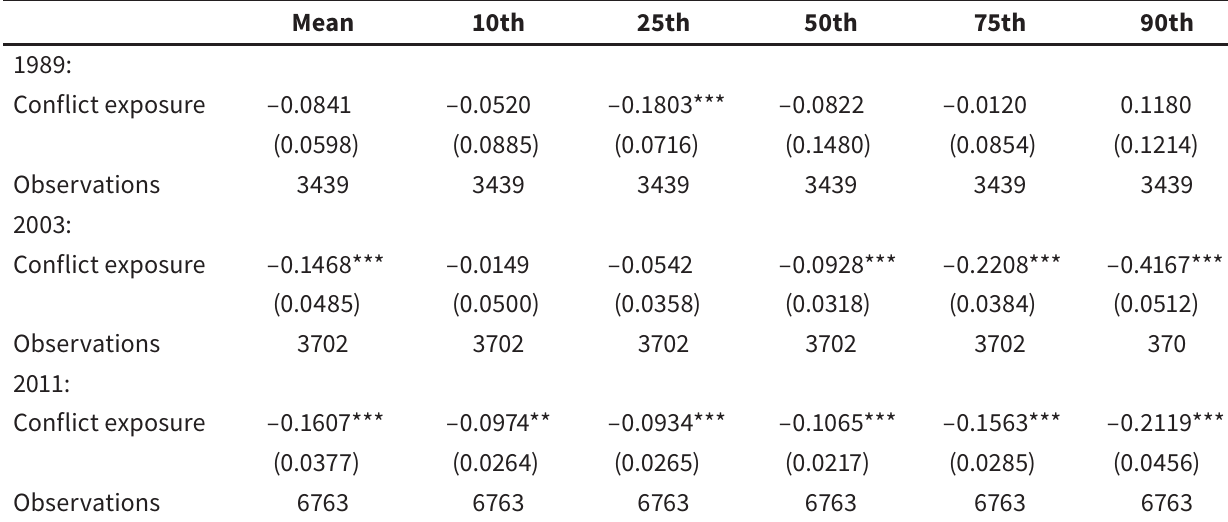
OLS and Quantile Treatment Effects using Log Household Expenditure – Conflict Exposure (using ≥7 years of rebel occupation as the